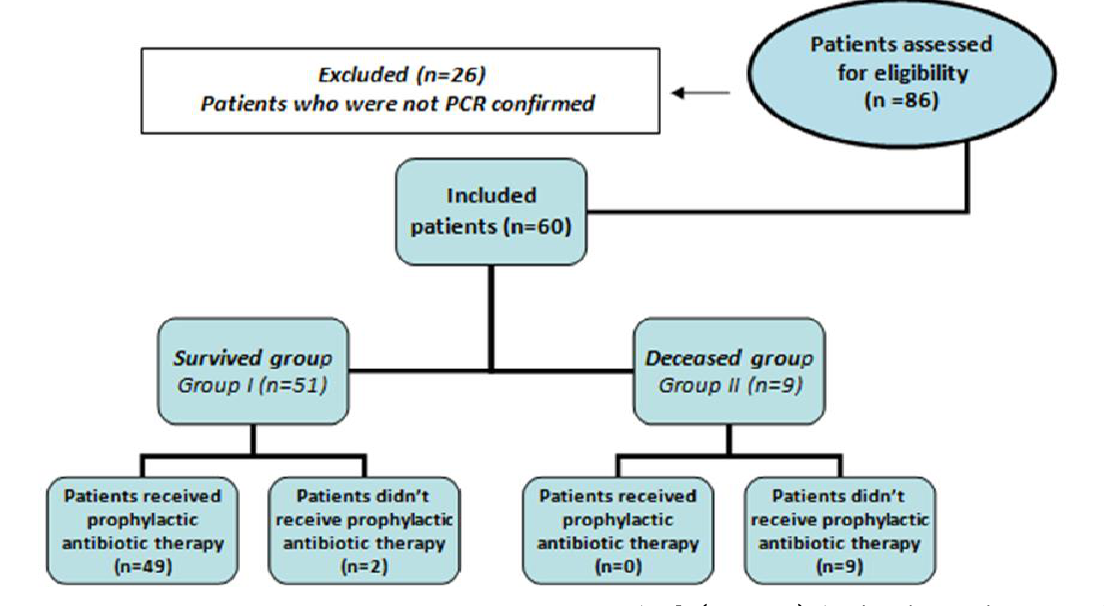
Figure 1. The study flow chart.